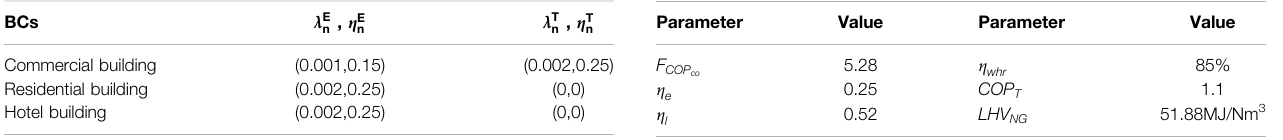
TABLE 7 | Equipment parameters in the